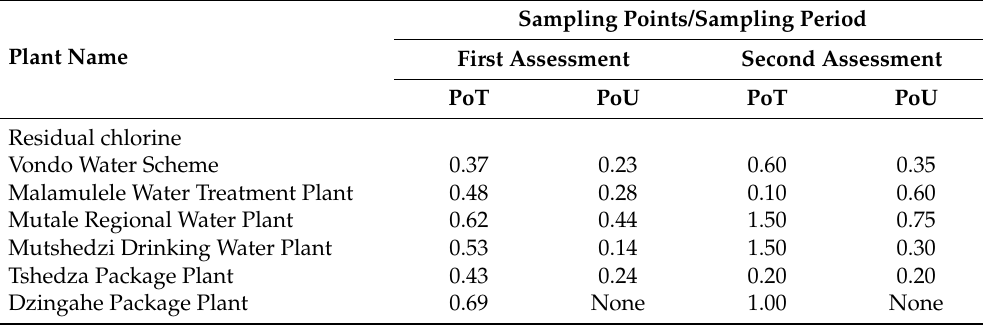
Table 6. Monitoring of residual chlorine (mg/L) in selected plants.